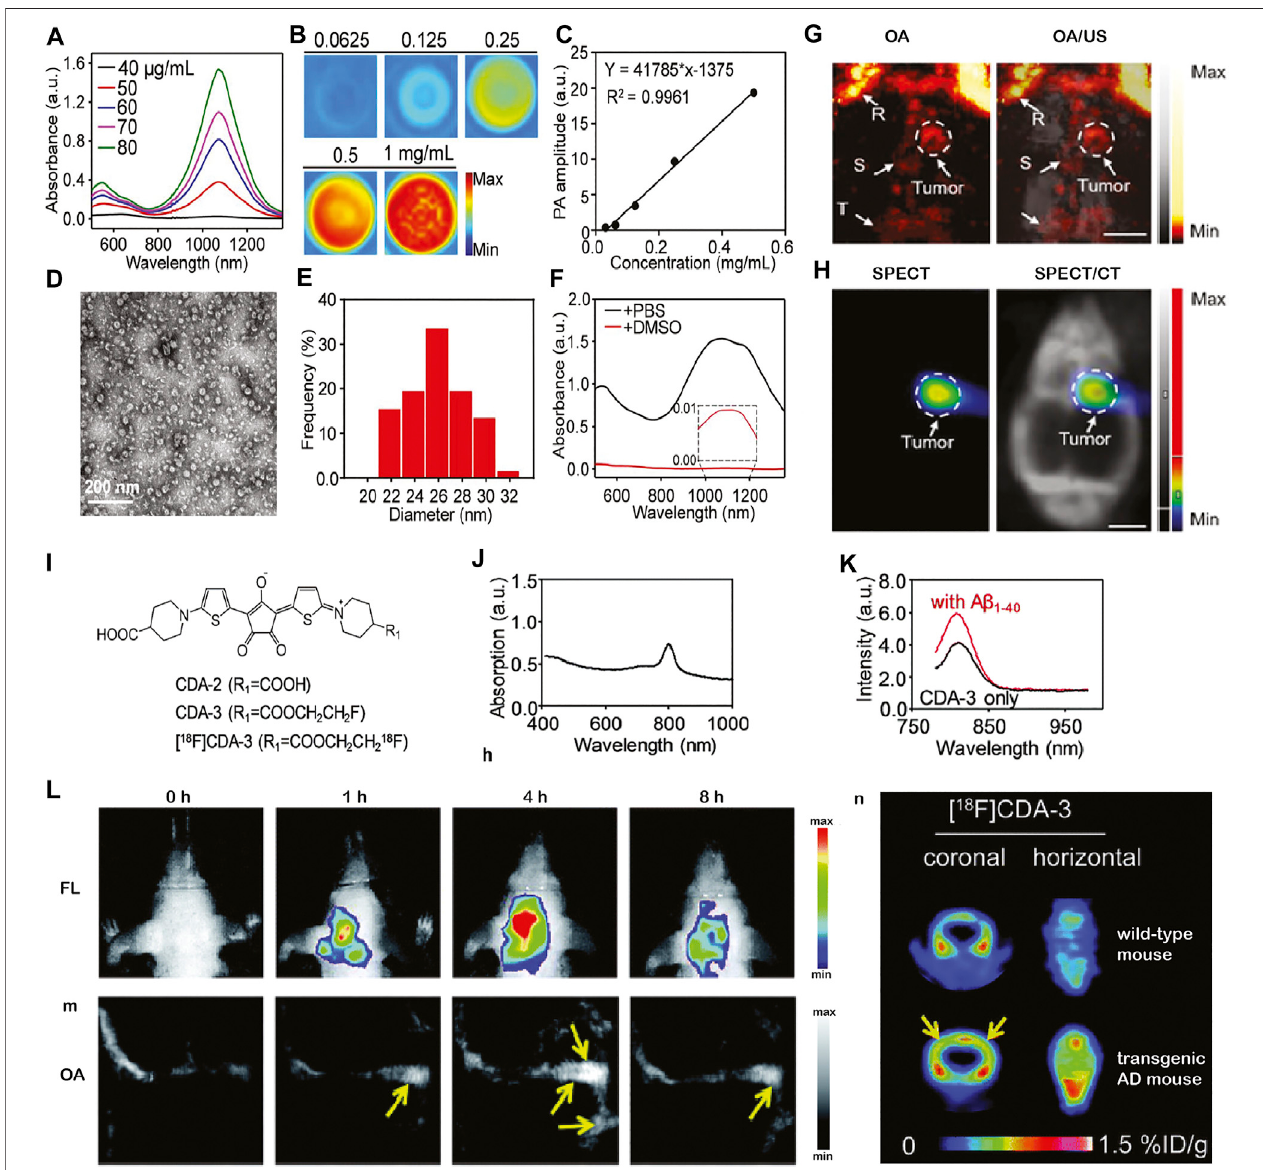
FIGURE1| In vivo multimodal optoacoustic (OA) brain imaging in small disease animal models. (A – H) Multimodal optoacoustic (OA) imaging in the brain of U87MG tumor-bearing mice using [ 131 I]A1094@RGD-HBc. (A – F) Characterization of the A1094@RGD-HBc; (A) absorption spectra of A1094; (B) OA images of A1094 at different concentrations at 950 nm in DMSO; and (C) relation between a OA signal and A1094 concentrations in DMSO. (D) Transmission electron microscope of A1094@RGD-HBc; (E) dynamic light scattering of A1094@RGD-HBc; (F) absorption spectra of A1094@RGD- HBc before/after 90% DMSO destroying the protein; (G) In vivo OA tomography/ultrasound images, and (H) microSPECT/CT images of the brain of U87MG tumor-bearing mice at 2 h after injection of [ 131 I]A1094@RGD-HBc; Scale bar (cid:1) 2 mm. R, rostral rhinal vein; S, sagittal sinus; T, transverse sinus; reproduced from ref. Liu et al. (2019a) with permission from the WILEY-VCH Verlag GmbH & Co. KGaA, Weinheim; (I – N) multimodal imaging of cerebral amyloid- β plaque in an Alzheimer ’ s disease mouse model. (I) Chemical structure of [ 18 F]CDA-3; (J) UV-vis absorption curve of CDA-3; (K) fl uorescence intensity of CDA-3 with/without A β 1 – 40 aggregates; (L – N) in vivo OA tomography/positron emission tomography/near-infrared fl uorescence imaging of brain amyloid-beta plaque detection in the Alzheimer amyloidosis mouse model. Reproduced from ref. Liu et al. (2017) with permission from the Royal Society of